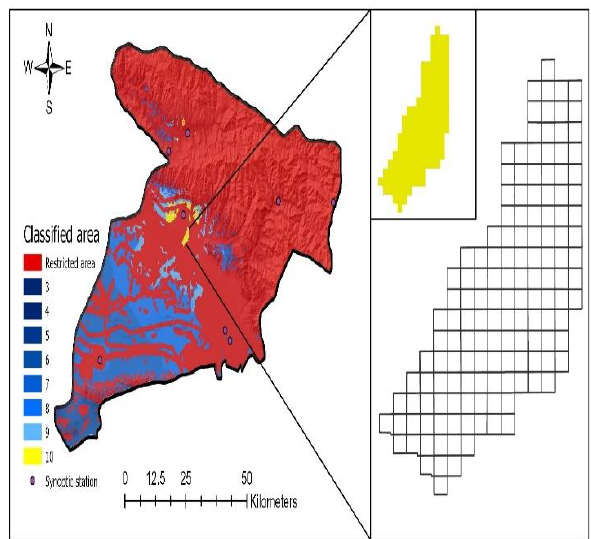
Figure 7 . Suitability map and the selected area.